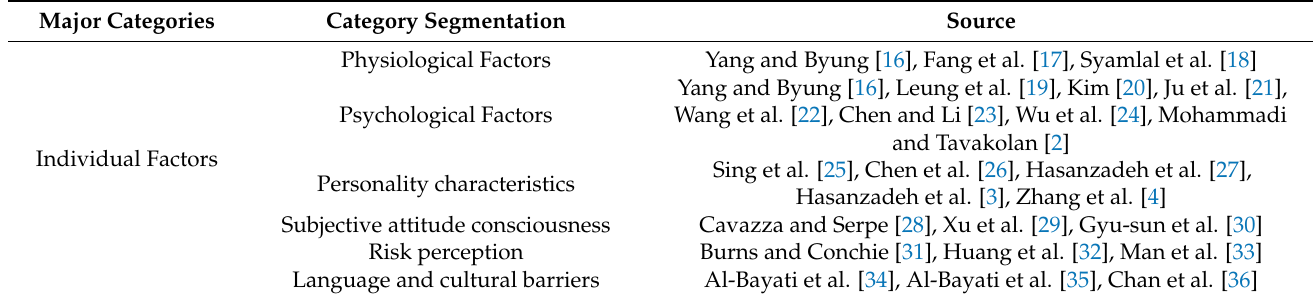
Table 2. Individual